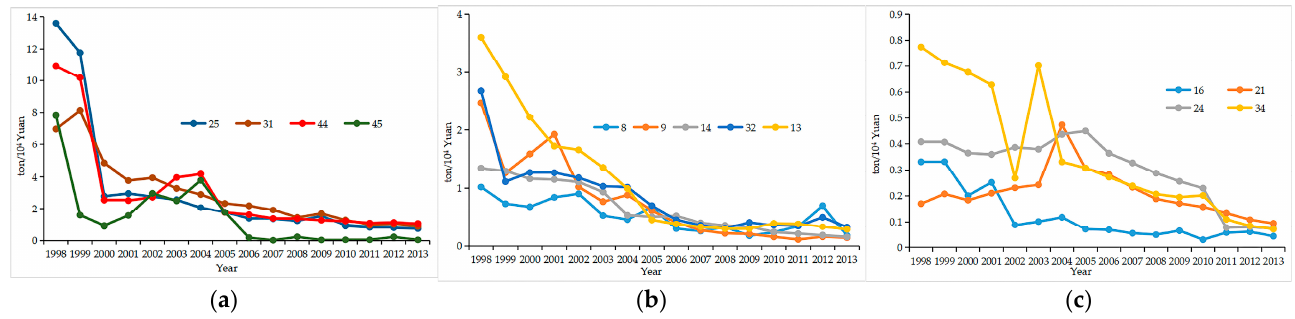
Figure 10. Changes in Carbon Emission Intensity of Some Industrial Sectors in Guangdong from 1998 to 2013. ( a ) industry codes: 25, 31, 44, 45; ( b ) industry codes: 8, 9, 13, 14, 32; ( c ) industry codes:16, 21, 24, 34.